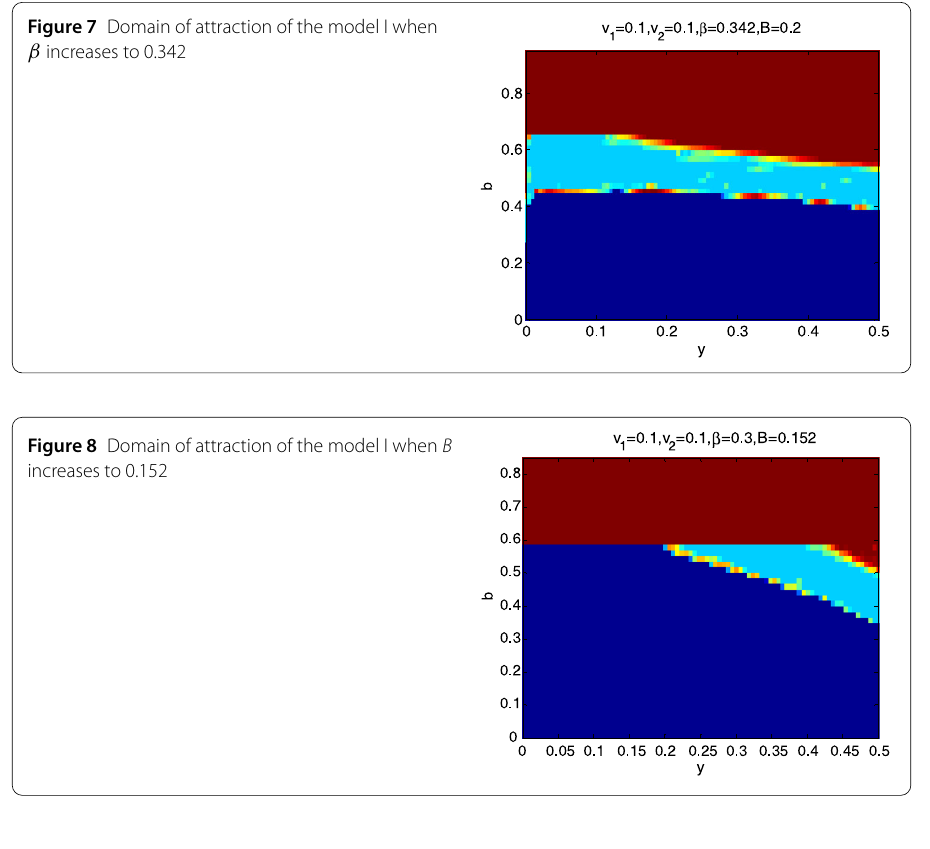
Figure 7 Domain of attraction of the model I when β increases to 0.342